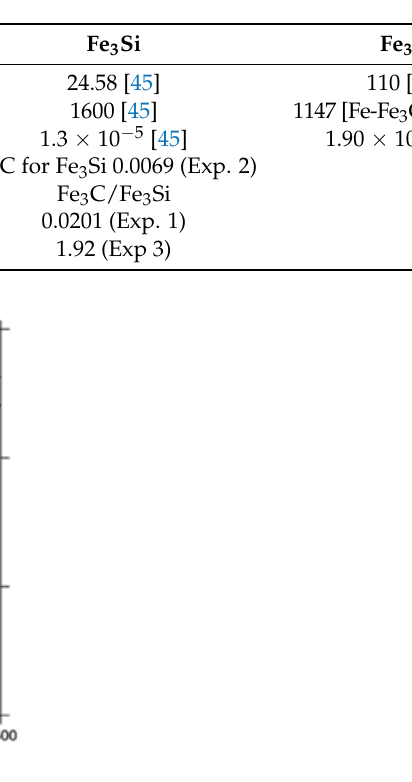
Table 7. Calculations of the CPC and CIC parameters in the area of the Fe 3 C/FeSi and Fe 3 C/Fe 3 Si phase interface.